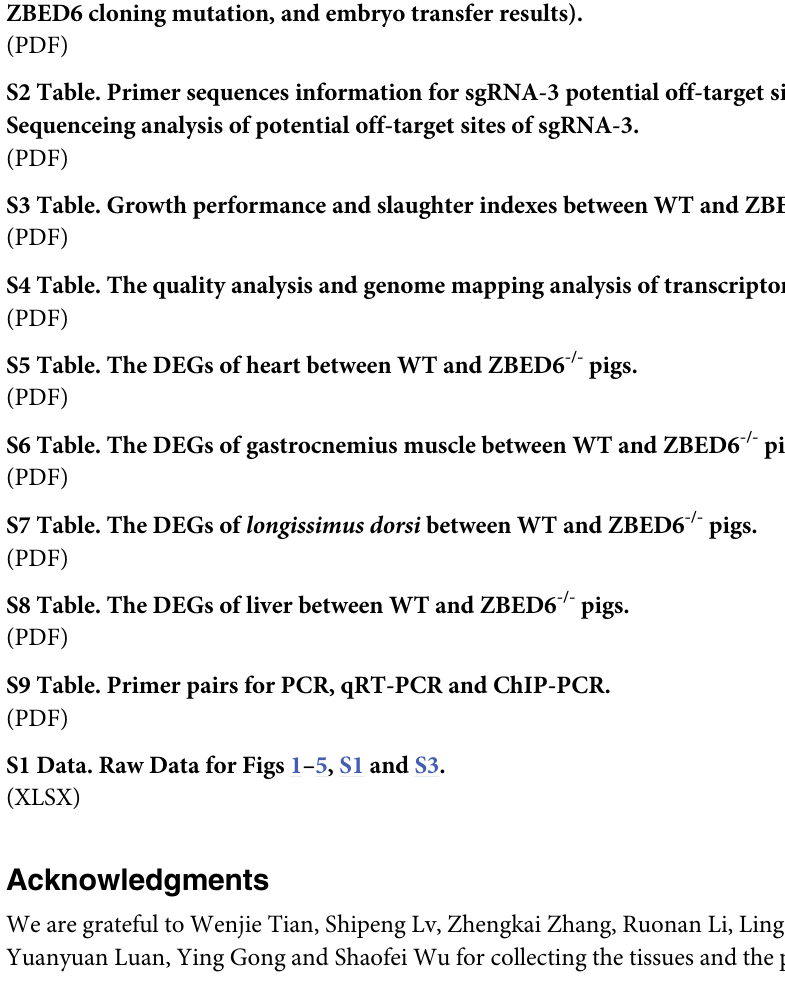
S1 Table. Summary of the ZBED6 gene editing (four sgRNAs sequences, efficiency of ZBED6 cloning mutation, and embryo transfer results). S2 Table. Primer sequences information for sgRNA-3 potential off-target sites, and Sequenceing analysis of potential off-target sites of sgRNA-3. S3 Table. Growth performance and slaughter indexes between WT and ZBED6 -/- . S4 Table. The quality analysis and genome mapping analysis of transcriptome sequencing. S5 Table. The DEGs of heart between WT and ZBED6 -/- pigs. S6 Table. The DEGs of gastrocnemius muscle between WT and ZBED6 -/- pigs. S7 Table. The DEGs of longissimus dorsi between WT and ZBED6 -/- pigs. S8 Table. The DEGs of liver between WT and ZBED6 -/- pigs. S9 Table. Primer pairs for PCR, qRT-PCR and ChIP-PCR. (PDF) S1 Data. Raw Data for Figs 1–5, S1 and